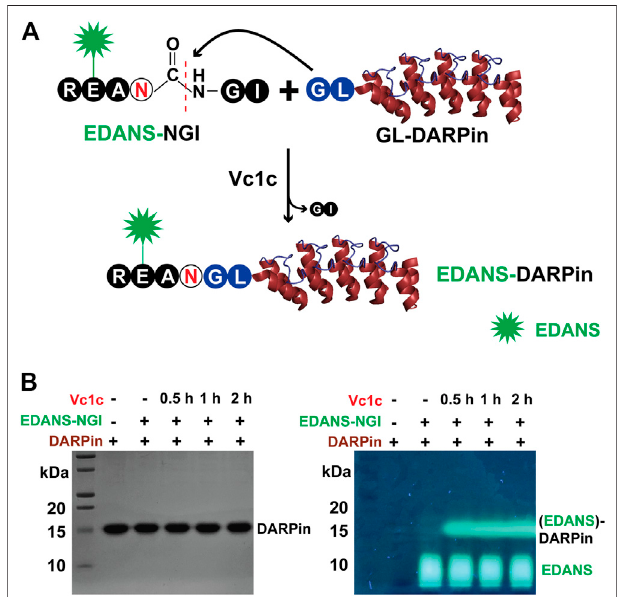
FIGURE 5 | Vc1c-mediated protein labelling. (A) Schematic of Vc1c- mediated ligation of DARPin (generated from PDB code 2QYJ) with fl uorescent peptide RE(EDANS)AN-GI. A fl uorescent peptide RE(EDANS)AN- GI was synthesized and DARPin9_26 was co-expressed with an N-terminal Gly-Leu dipeptide. The ligase can recognize and cleave the C-terminal Gly-Ile of the fl uorescent peptide, and ligate it to the GL- DARPin9_26 N terminus. (B) Left panel: SDS-PAGEgel after Coomassie blue staining showing bands for DARPin9_26 around 15 kDa; Right: SDS-PAGE gel under UV illumination. The reaction was performed at 37 ° C, pH 6.5 with 20 nM Vc1c and 4 μ M DARPin9_26.